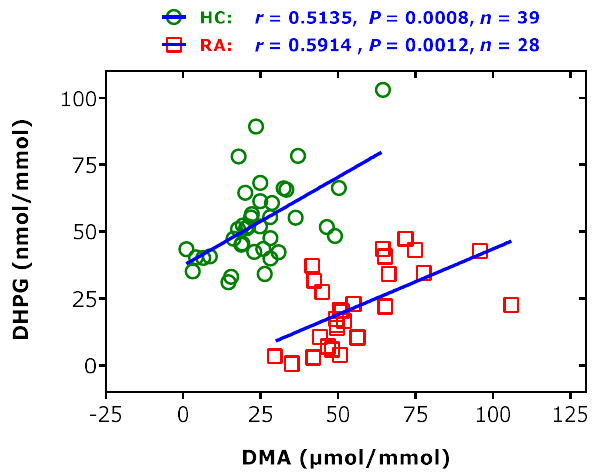
Figure 9. Spearman correlation and linear regression analyses between the creatinine-corrected excretion rates of dihydroxyphenylglycol (DHPG) and dimethylamine (DMA) in 39 healthy controls (HC) and in 28 subjects suffering from rheumatoid arthritis (RA). This Figure was constructed with data reported in part elsewhere [46,62].